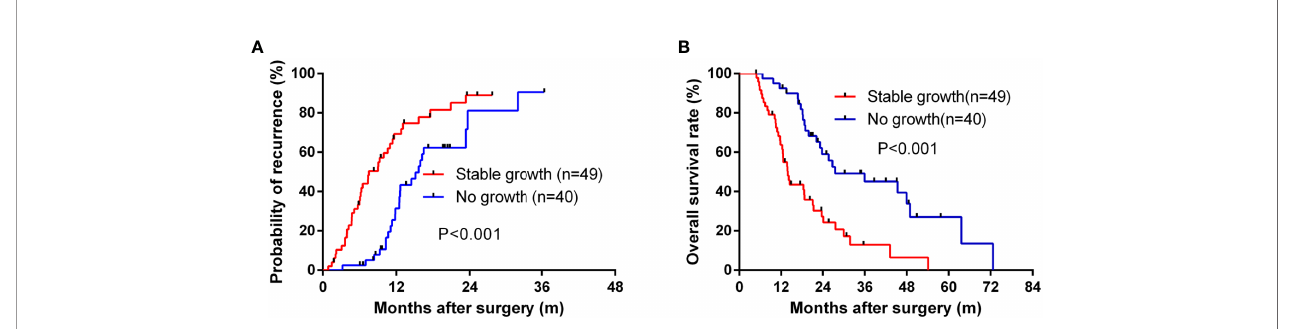
FIGURE 2 | The Kaplan – Meier analysis of TTR and OS for the stable growth of grafts. (A) for TTR and (B)